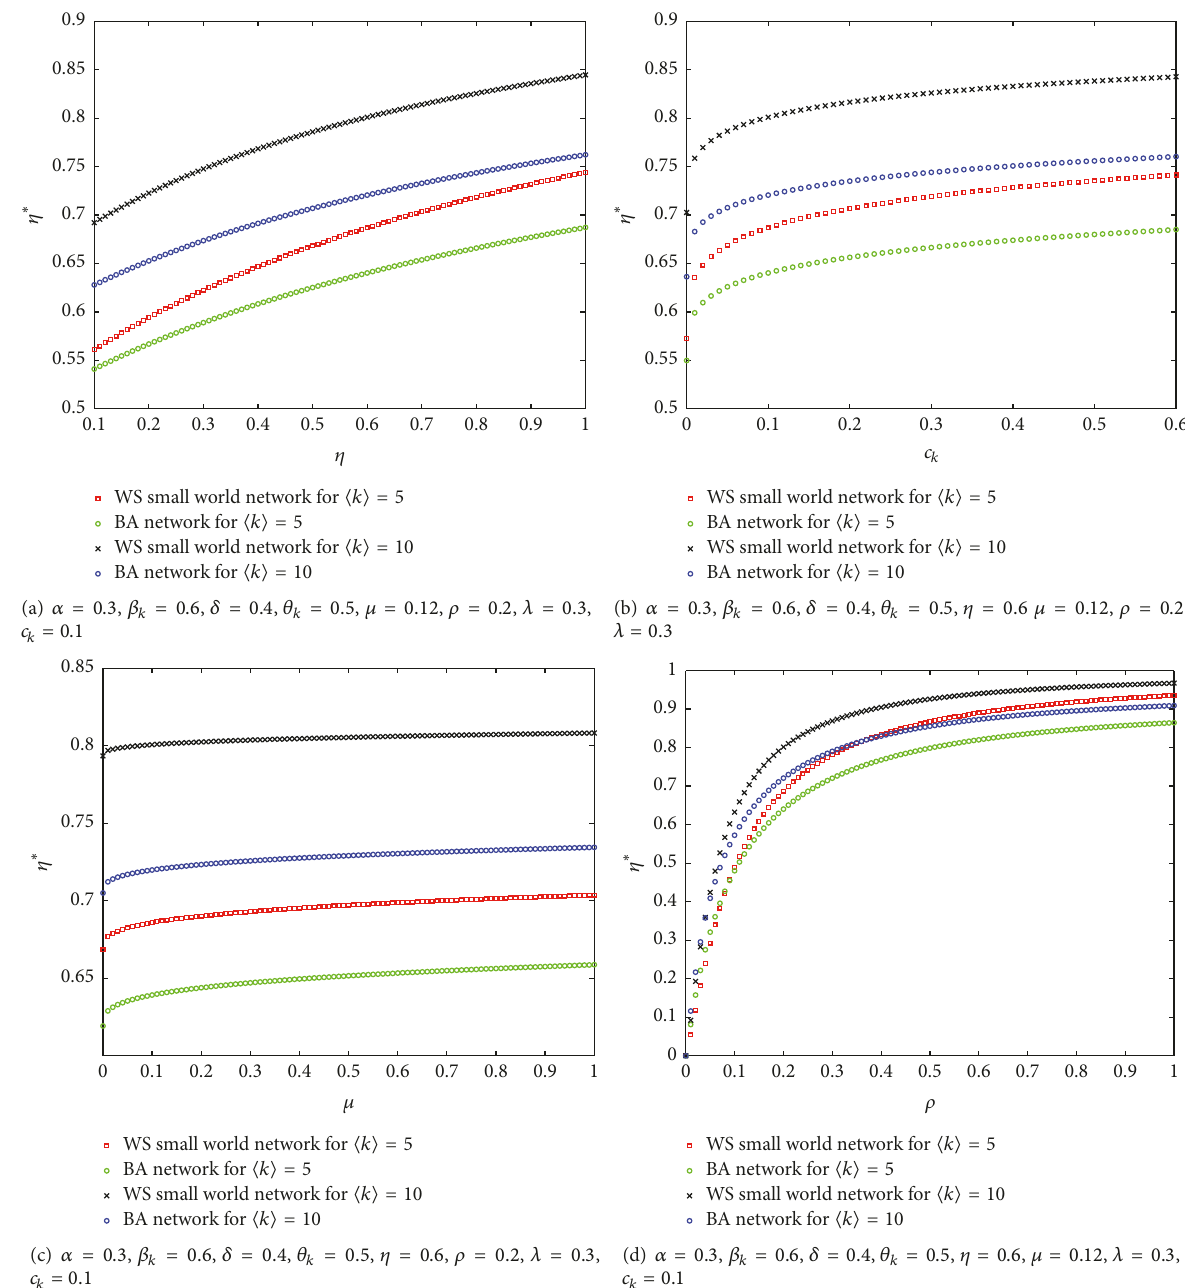
WS small world network for ⟨k⟩ = 5 BA network for ⟨k⟩ = 5 WS small world network for ⟨k⟩ = 10 BA network for ⟨k⟩ = 10